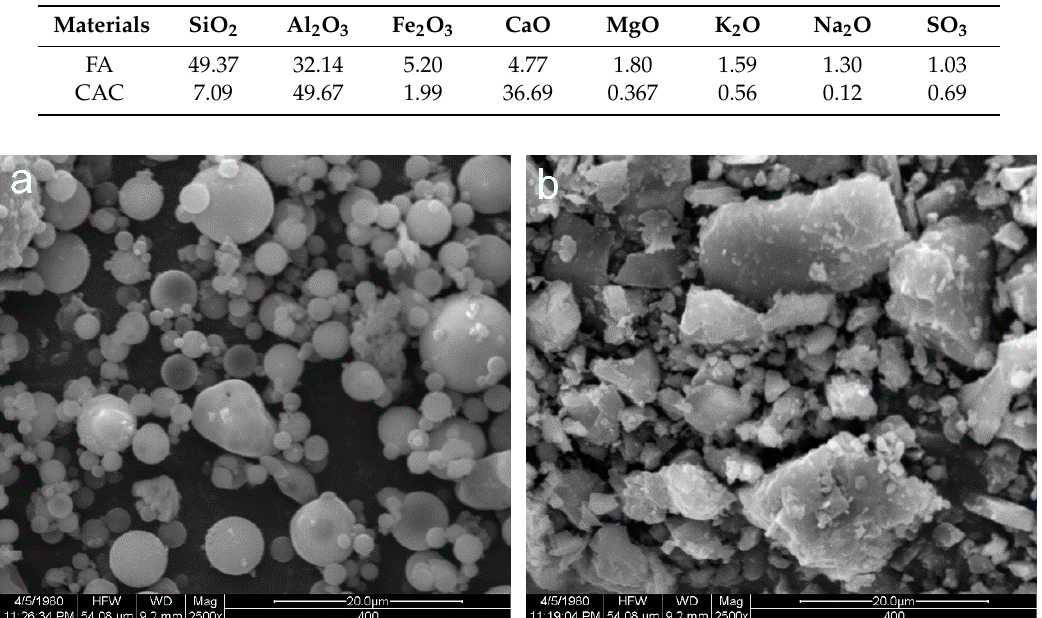
Table 2. Details of mix proportion (kg / m 3